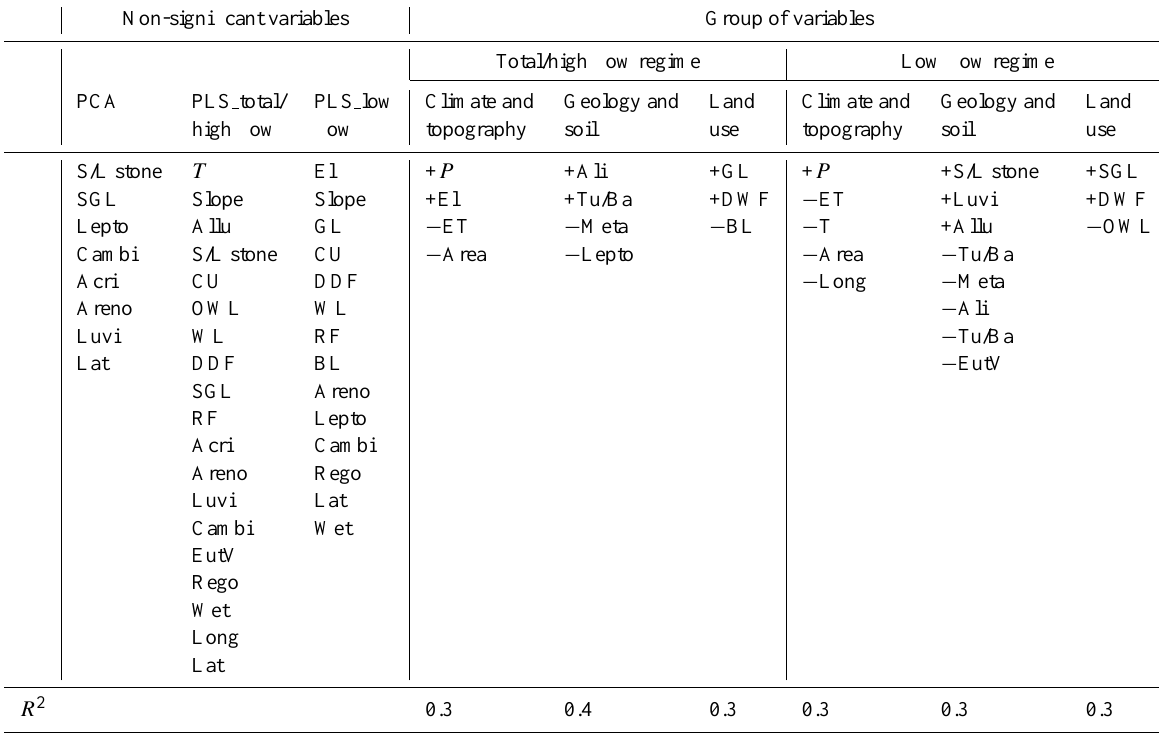
Table 2. Influence of explanatory variables. The “Non-significant variables” were determined from the 90% confidence interval. “Group of variables” column shows the relation of groups of explanatory variables for explaining response variables (flow parameters), as summarized from PLS analysis. a ,